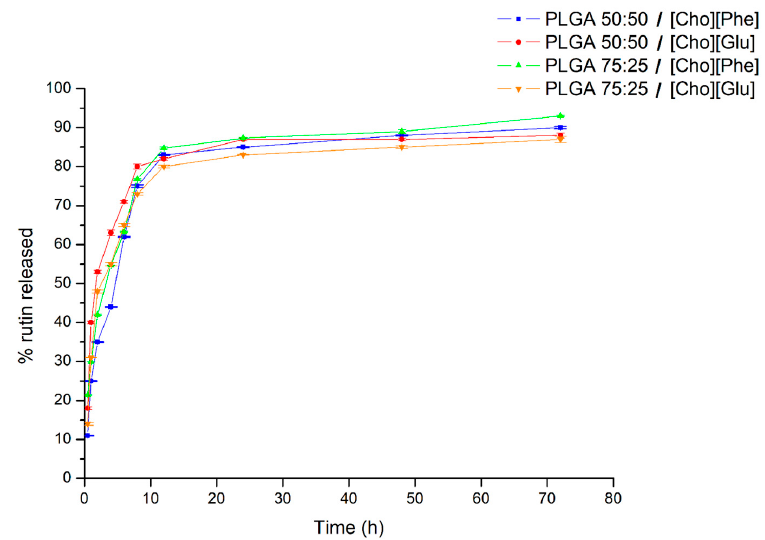
Figure 6. Release profile of the rutin-loaded IL-PLGA nanoparticle hybrid systems during 72 h in phosphate buffer saline at pH 7.4. Data represented as mean ± SD ( n = 3). phosphate bu ff er saline at pH 7.4. Data represented as mean ± SD ( n =